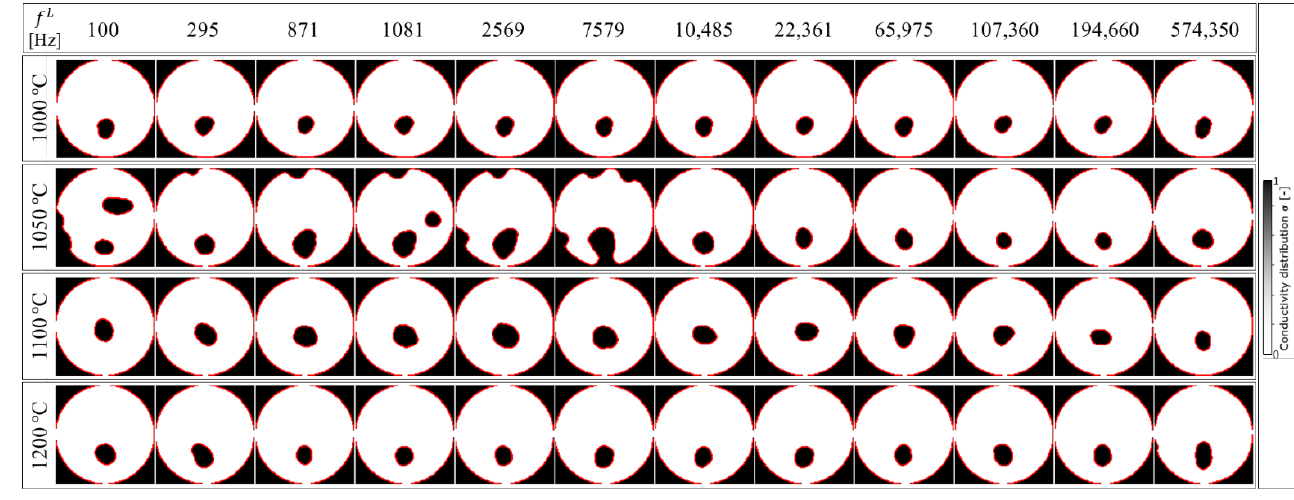
Figure 13. Image binarization.